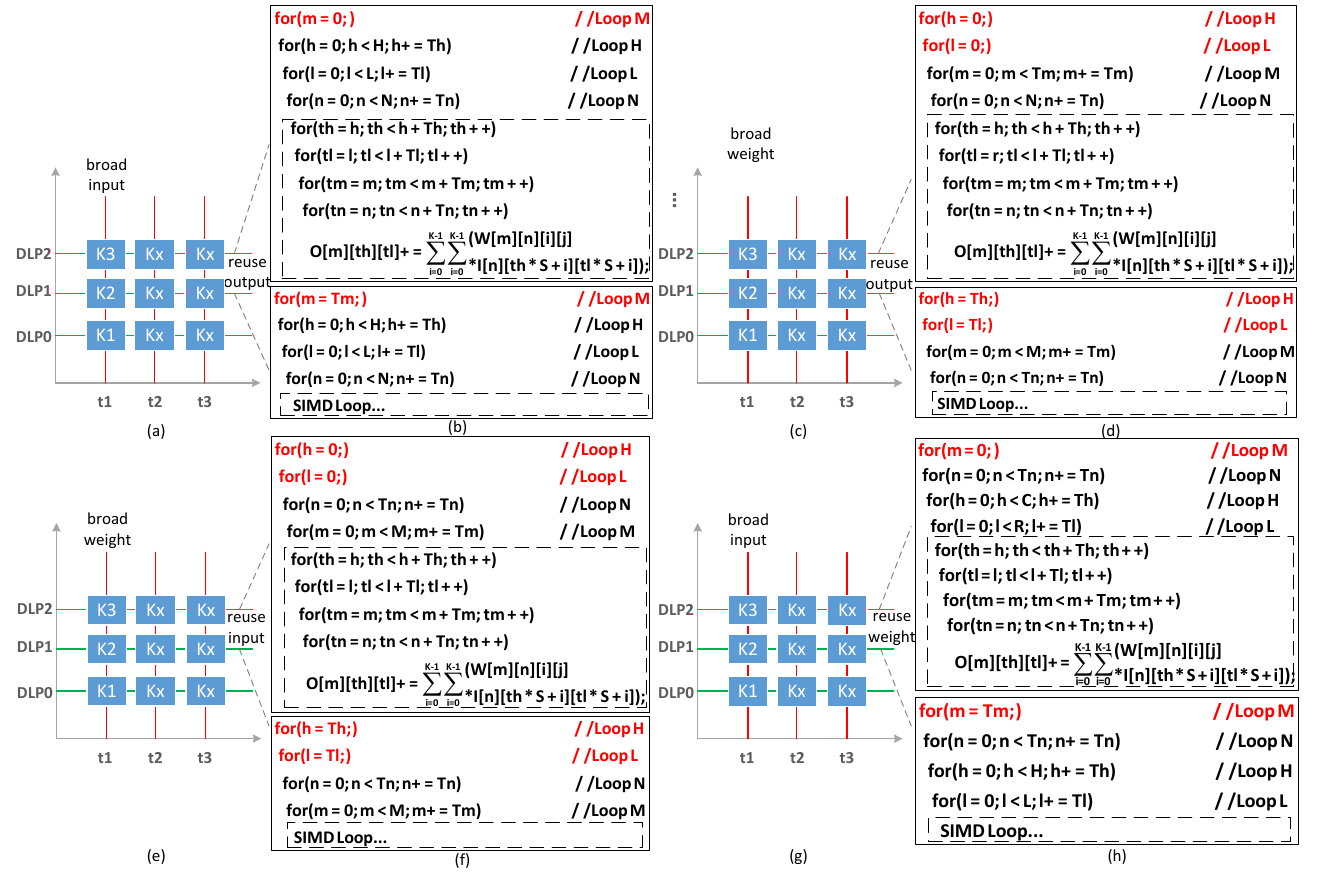
Figure 10. Data reuse and broadcast pattern: OR/IB, OR/WB, IR/WB, WR/IB ( a , c , e , g ) refer to their execution. ( b , d , f , h ) refer to their